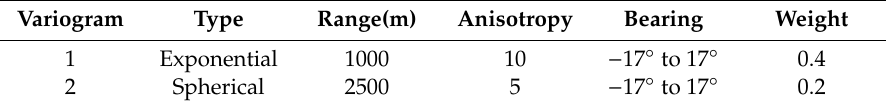
Table 3. Geostatistical structure used for hydraulic conductivity field generation.